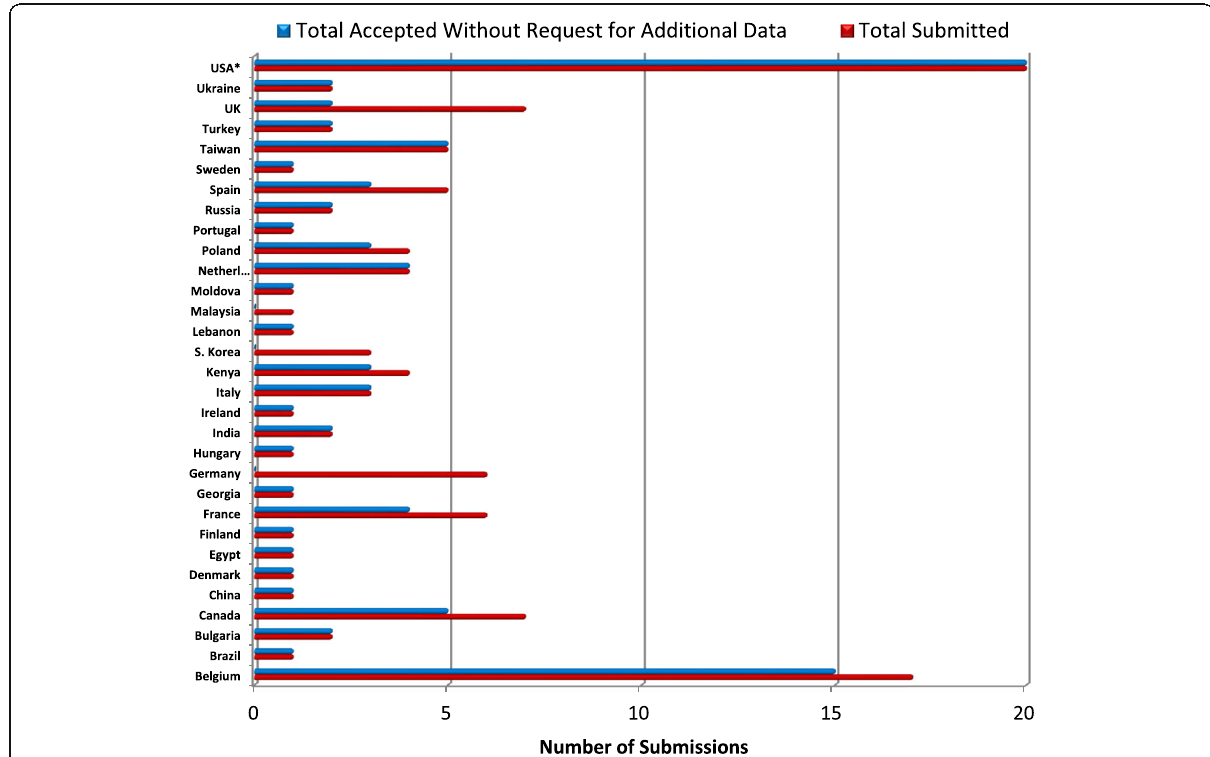
Fig. 3 RBPS Regulatory Experience by Country (2009 – 2018). *USA Bar is truncated (35 accepted without requests for additional